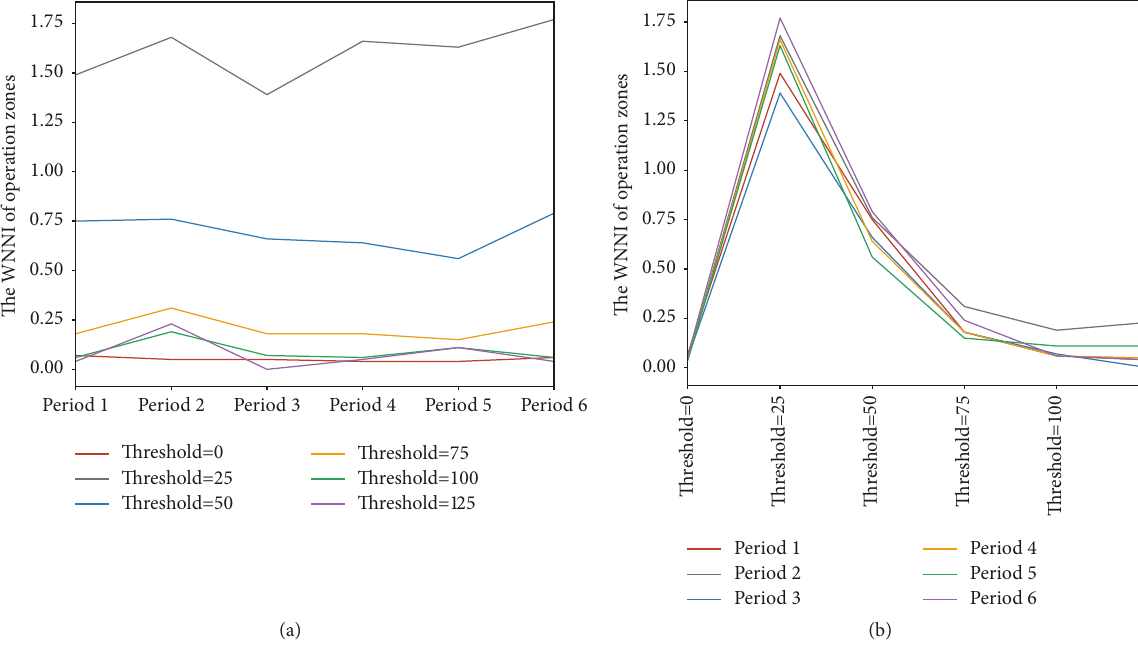
Figure 7: The distribution of WNNI with respect to periods (a) and thresholds